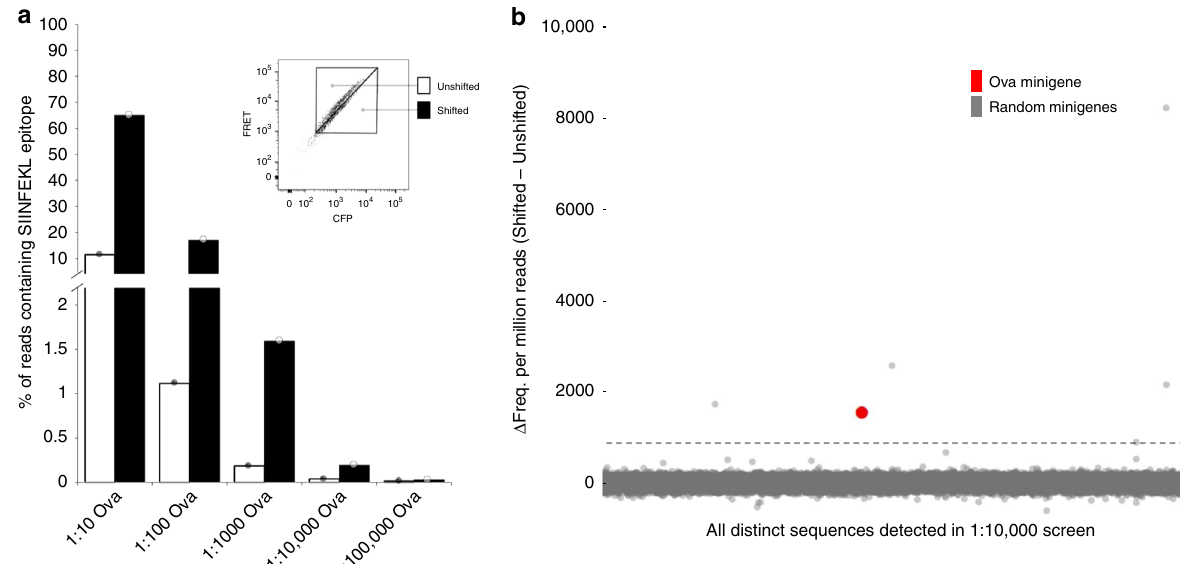
Fig. 3 OT-I spiked library screening. Random minigene cell libraries spiked with Ova minigene-expressing cells were co-incubated with OT-I CTL at a 1:1 effector:target ratio for 4 h prior to FACS analysis. Recovered cells were lysed and integrated minigenes were ampli fi ed from genomic DNA using PCR primers speci fi c for the conserved transgene region fl anking the minigene site. Primers with indexed Illumina adapter tails were used for direct sequencing of amplicons on the Illumina MiSeq platform with 2 × 250 paired-end chemistry. a The percentage of reads detected in each gate that encoding the SIINFEKL epitope. Filled circles underlaid with white bars represent Unshifted gate; open circles underlaid with black bars represent Shifted gates. Each point represents one individual measurement. Source data are provided as a Source Data fi le. b The read count frequency of all unique sequences found in 1:10,000 spike-in sample expressed as the difference between the relative frequency in the Shifted gate and the Unshifted gate. The dashed line represents 10 σ above the mean Δ relative abundance